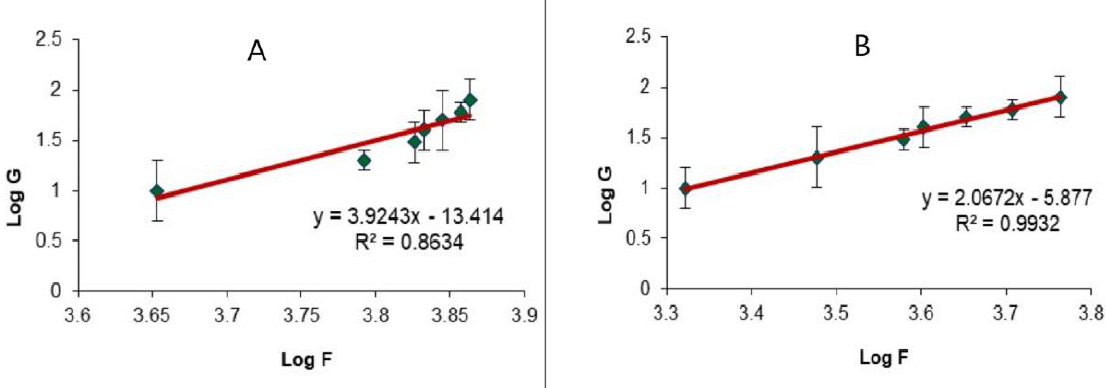
Figure 7. Plots of the logarithm of the shear rate (G) versus the logarithm of the shear stress (F) for ( A ) nanoemulgel loaded with optimized LV-Eu-SNEDDS and ( B ) Carbopol 934 hydrogel (plain). Values are expressed as the mean ± SD ( n = 3).